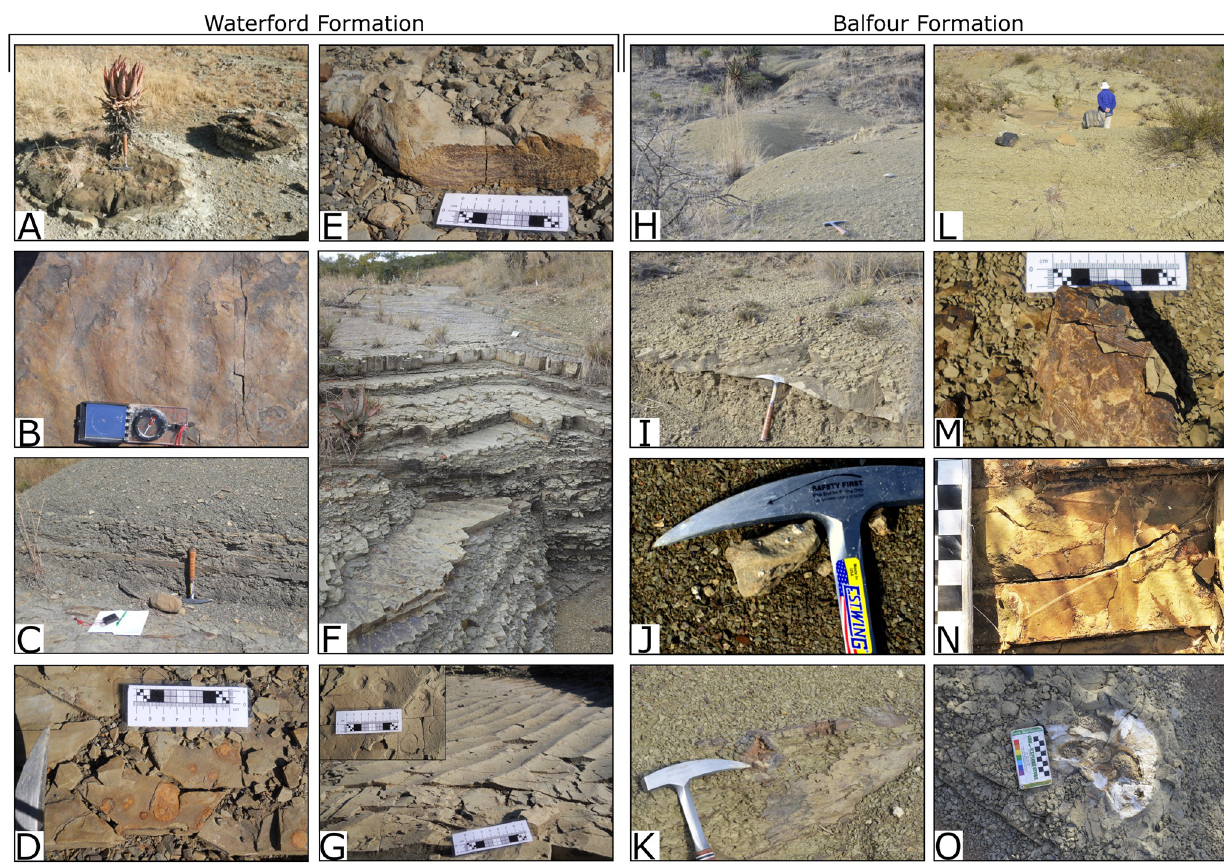
Fig 3. Features of the upper Waterford and lower Balfour formations in the study area. A) Large calcareous nodules. B) Rounded/ Smoothed symmetrical ripples on the top of the thick sandstone unit. C) Dark grey, laminated mudstones. D) Iron oxide haloes in sandstone unit. E) Soft sediment deformation. Note how the laminations follow the deformation bed. F) Sequence of rhythmites, comprising alternating mudstone and sandstone units. G) Large symmetrical ripples with sharp, straight crests and Skolithos burrows. H) Yellow-green mudstones typical of this facies association. I) Sandstone lens showing lateral/ downstream accretion. J) Calcareous concretions within a sandstone. K) Slickenside surfaces and nodules in mudstones. L) Fossilised wood weathering out of the mudstones. M) Horsetail impressions. N) Glossopteris leaf impressions. O) Large, unidentified bone c.f.